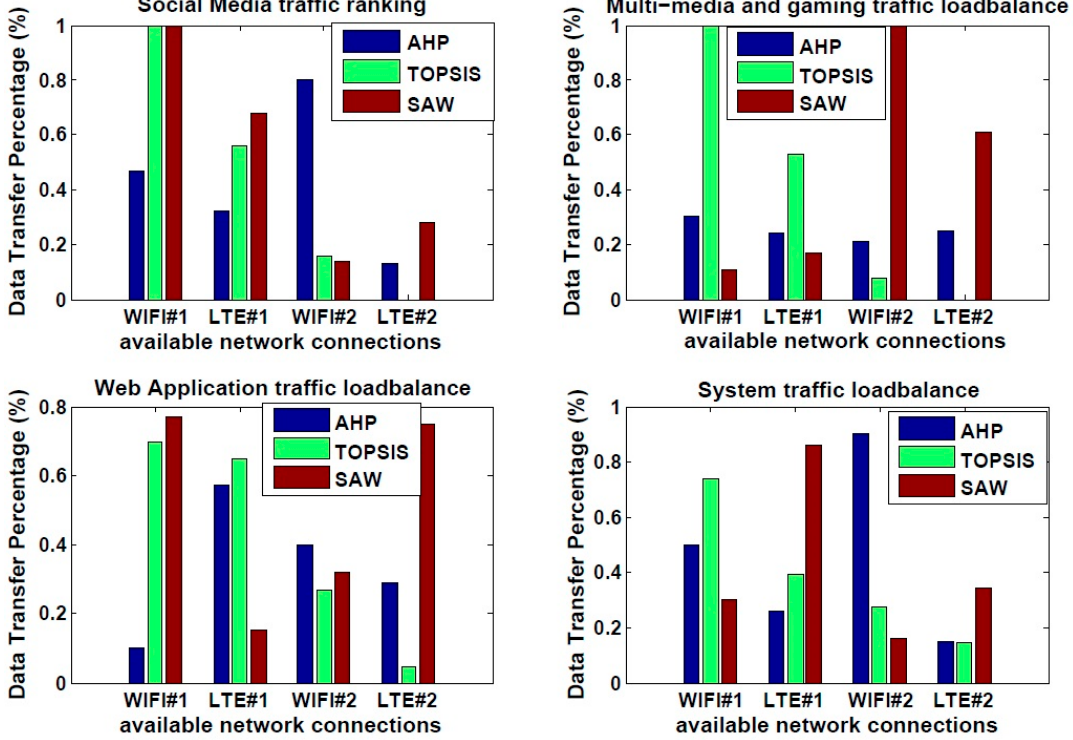
Figure 7. Performance analysis of three MADM methods.